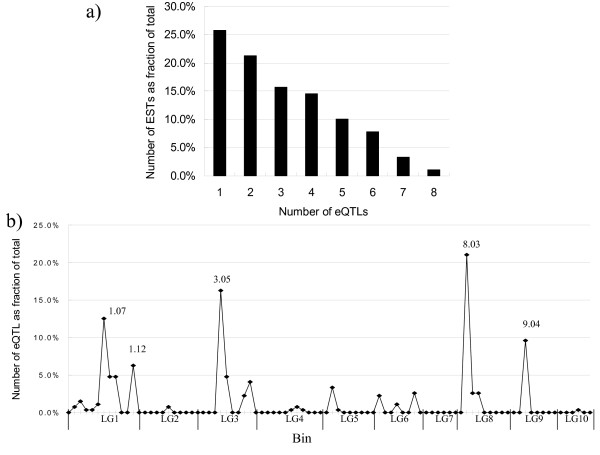
Expression quantitative trait loci (eQTL) (LOD ≥ 2.4) distributions. a) Distribution of numbers of eQTLs detected for corresponding EST; b) Genome-wide distribution of eQTLs according to the bins.